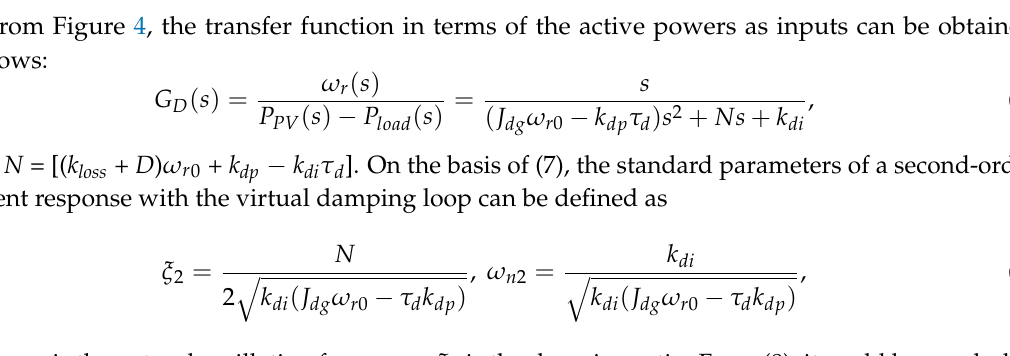
Figure 4. DGS speed control with the virtual damping control loop.